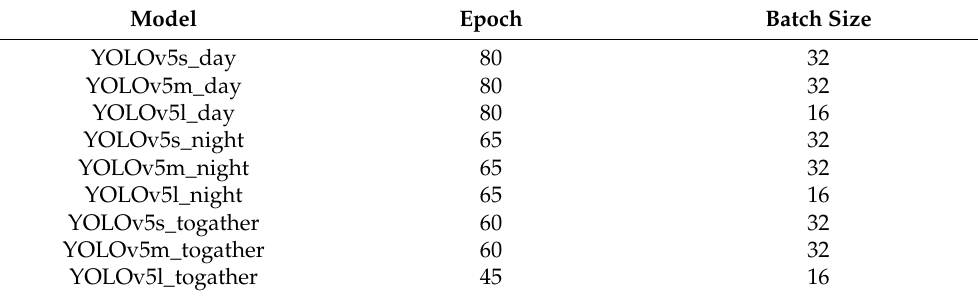
Table 1. YOLOv5 parameter settings.